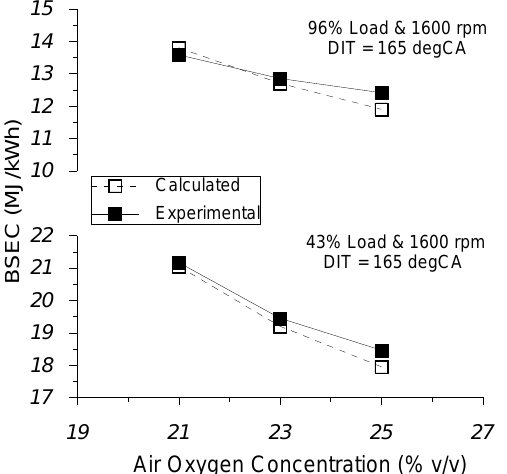
Figure 3. Comparison between experimental and computed BSEC as a function of “inlet-air oxygen ratio”, for N = 1600 rpm and “a” = 20%, at 43% and 96% of engine rated load.